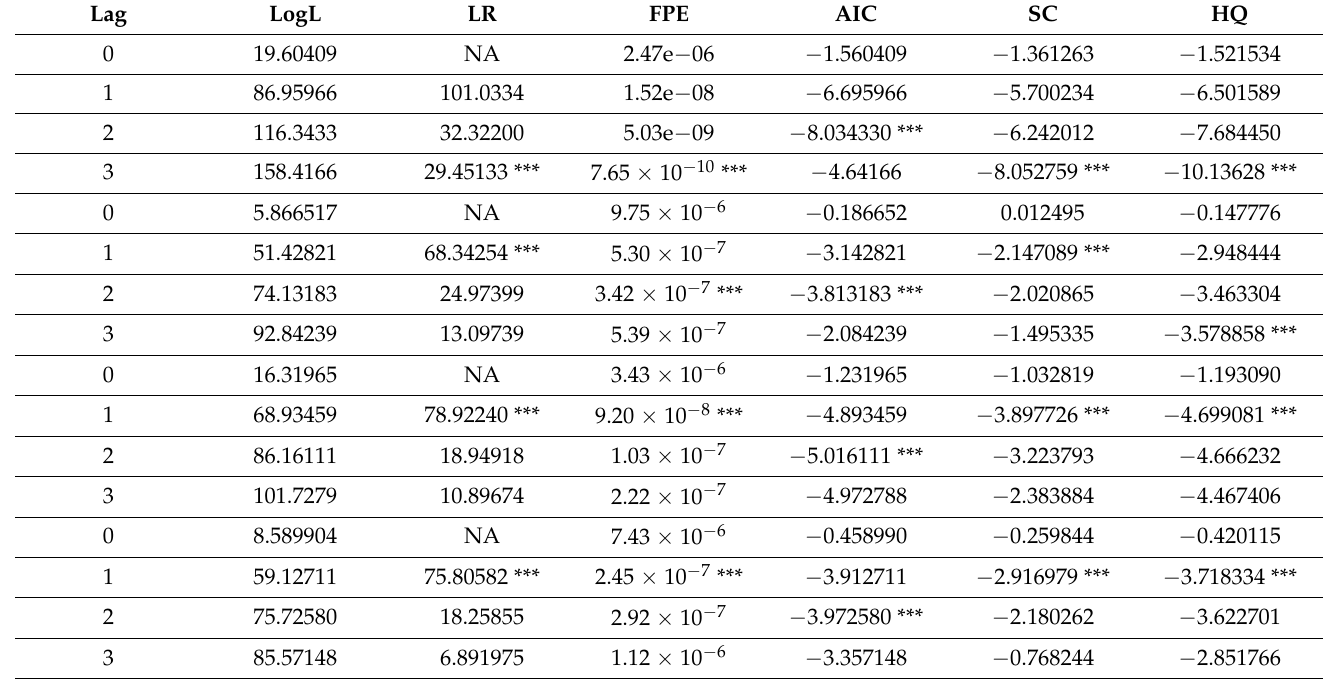
Table 6. Results of lag length criteria under VAR.